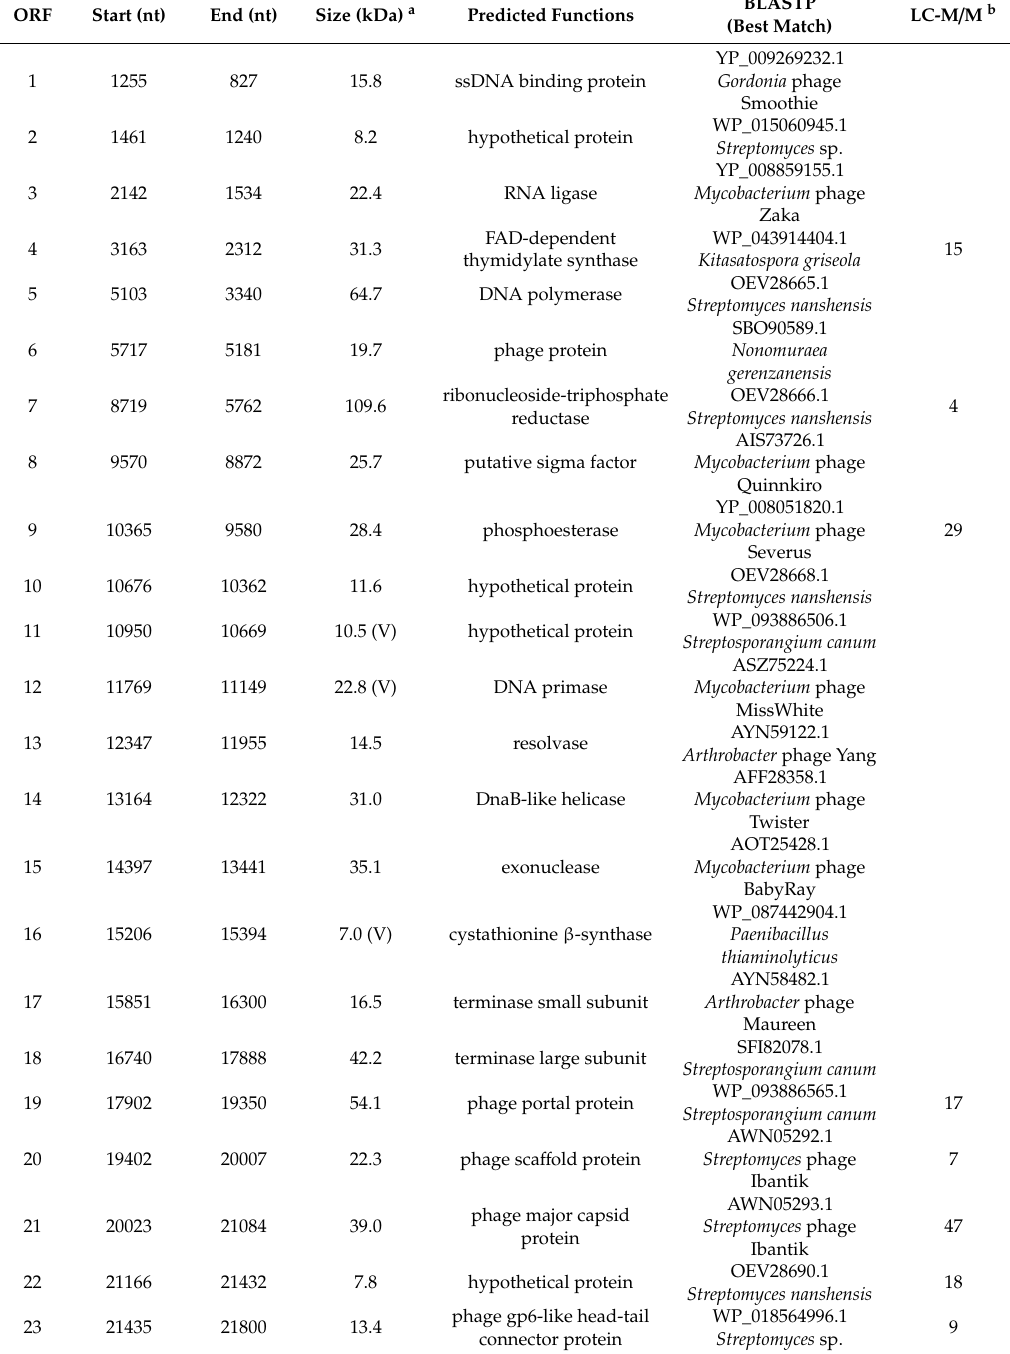
Table 1. General features of the proteins encoded by the predicted ORFs of the P318